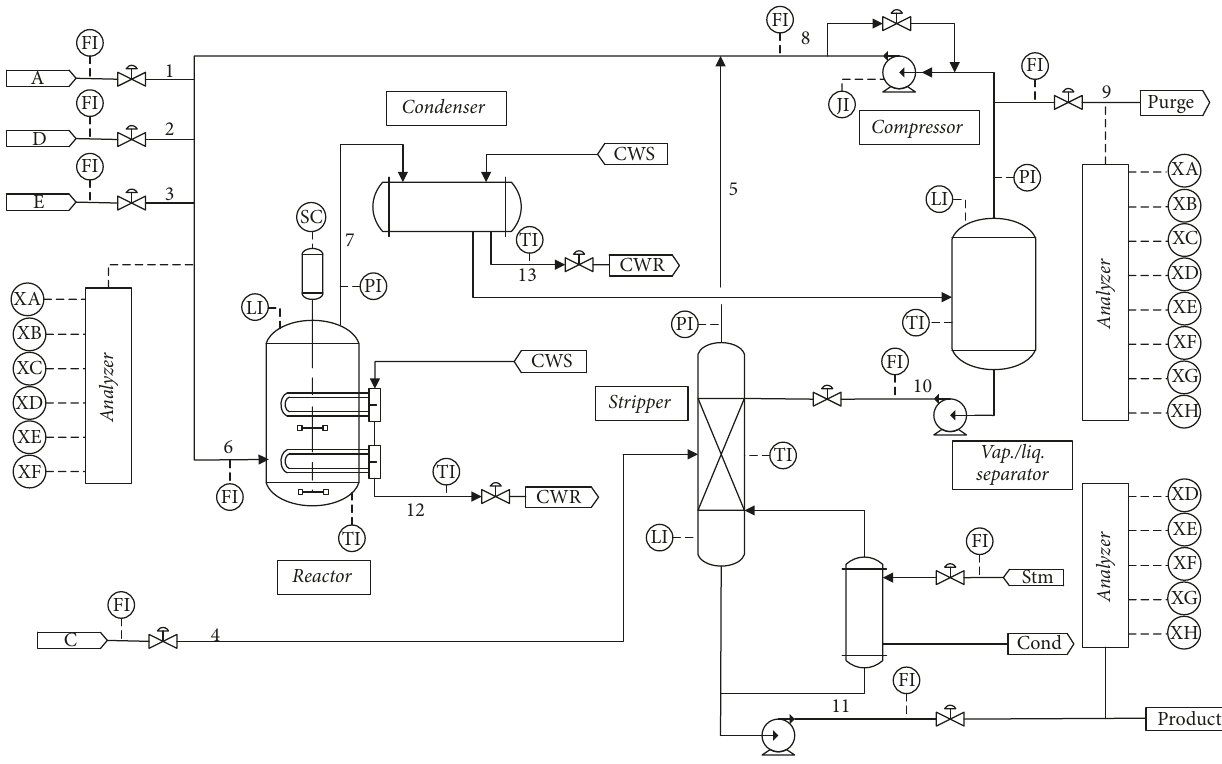
Figure 2: The Tennessee Eastman process.